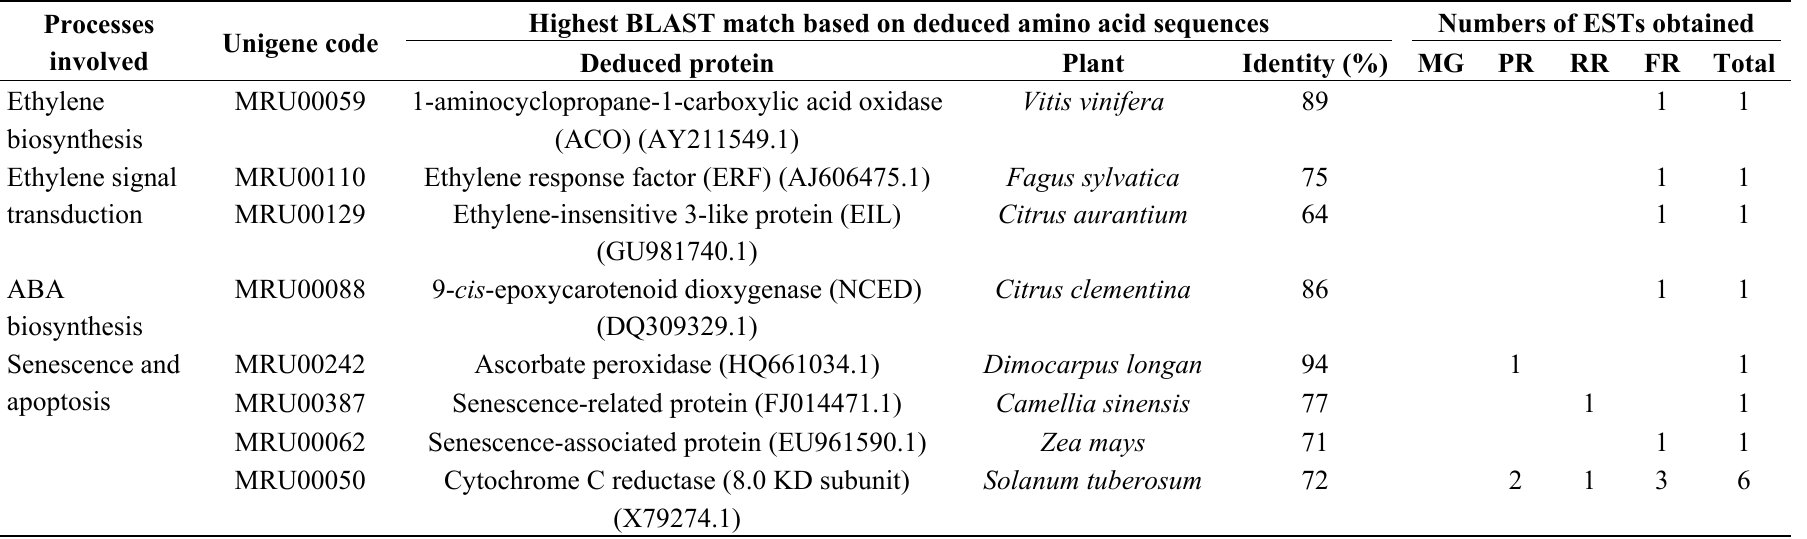
Table 4. Identification of genes associated with bayberry fruit ripening and senescence from “Biqi” fruit